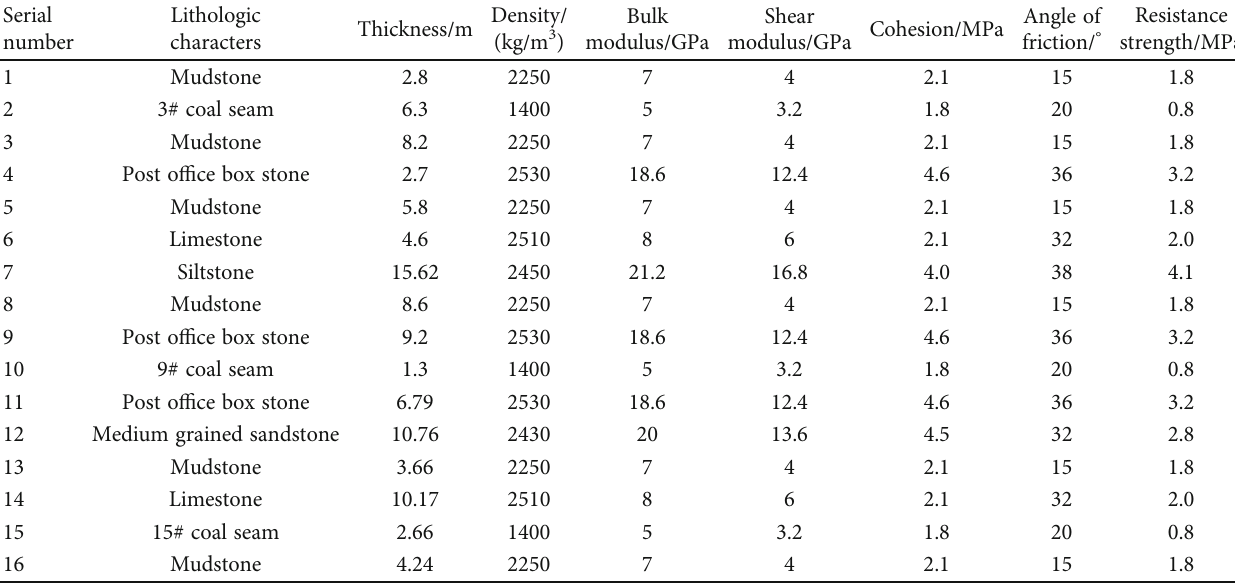
Figure 4: Figure of numerical model. Table 1: Physical and mechanical parameter table of coal and rock